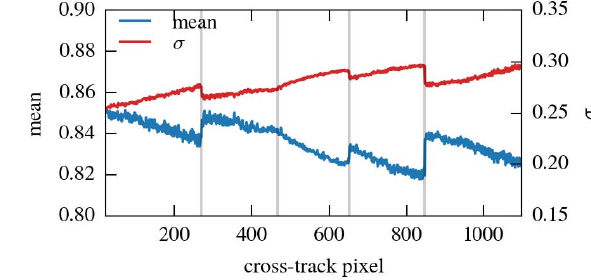
Figure 7. Along-track mean and standard deviation of cloud prob- ability for 2010. Vertical lines mark the transition between the five detectors of